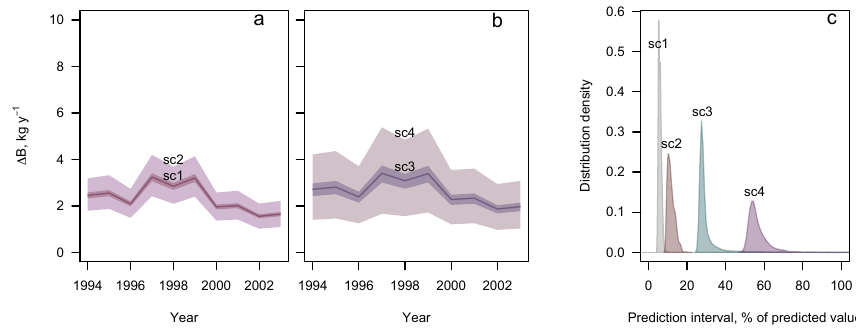
Figure 5. Annual biomass increment (posterior MCMC distribution) for one given tree chosen as representative with its associated prediction error for scenario 1 and 2 (a) or scenario 3 and 4 (b) ; (c) distribution density of relative prediction interval (expressed in percent of the prediction) for all trees included in the simulation, according to the scenario. Scenario 1 is based on constant WD and no random or residual error from the volume increment model, scenario 2 is based on constant WD and random error in the volume increment model, scenario 3 is based on modelled WD but without random and residual error accounting, and scenario 4 is based on modelled WD and volume increment, accounting for all error sources (see Sect. 2.3 for more details).